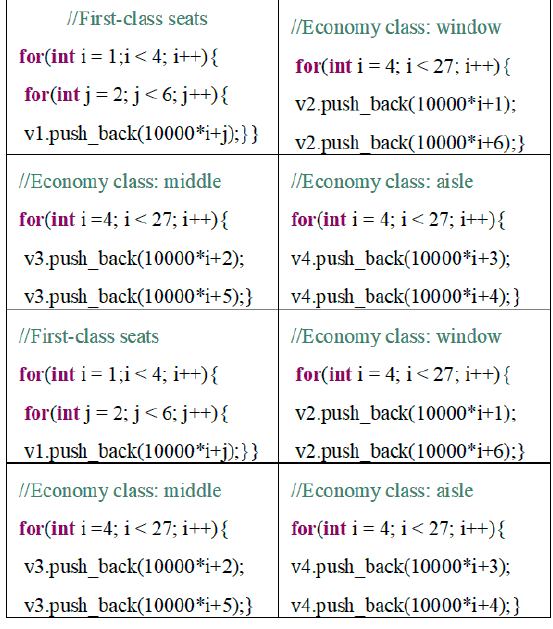
Figure 12. Zone rotate seat number generation.